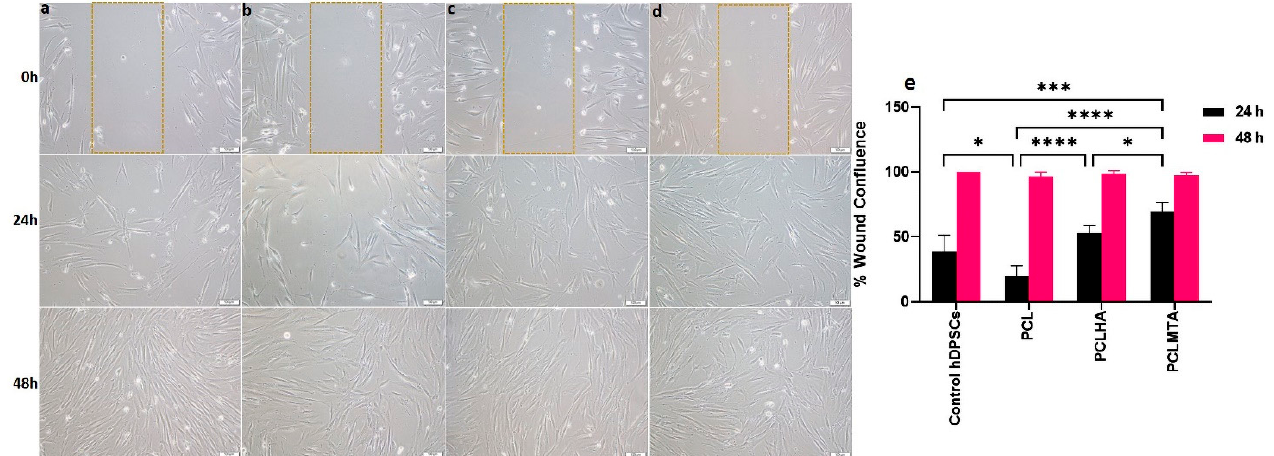
Figure 10. Representative phase contrast microscopic images of the wound healing ability of hDPSCs analyzed for 48 h when treated with different electrospun membrane extracts. The images were shown as: ( a ) control hDPSCs grown on glass coverslips in a normal cell culture medium, ( b ) hDPSCs in PCL membrane extract, ( c ) hDPSCs in PCLHA extract, and ( d ) hDPSCs in PCLMTA extract. The percentage of wound closure was calculated and is represented as a bar chart with mean ± SD ( e ). Statistical significance between the test groups is represented using asterisks; *, *** and **** with the p values <0.05, 0.001, and 0.0001, respectively. The scale bar in the figure is 100 μ m.